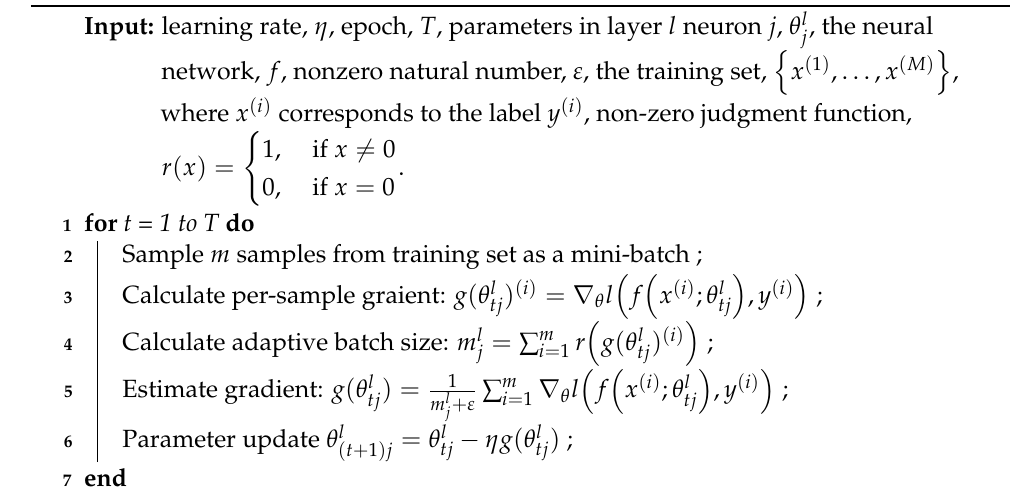
Algorithm 2: Sample-based adaptive batch size gradient